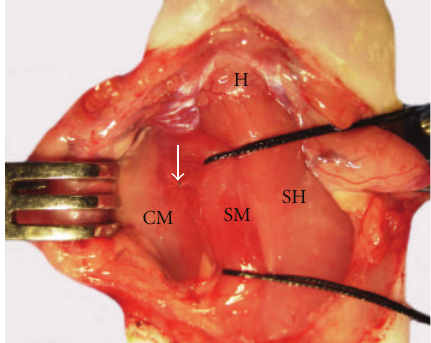
Figure 1: The SM nerve 3 months after transection and repair with EEA. Photograph from an open neck of a rat who underwent EEA procedure following transection of the SM nerve on the right side. After the SM was retracted medially by two sutures, its innervating nerve was visualized between the SM and cleidomastoid (CM) belies. The SM nerve was transected and both nerve cut ends were united with two 10-0 nylon sutures (white arrow). H: hyoid bone; SH: sternohyoid